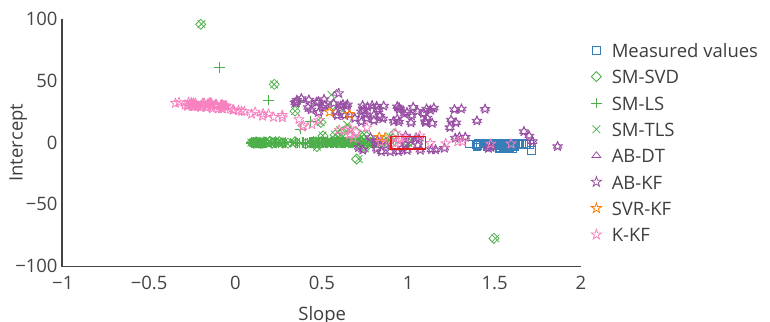
Figure 16. Target plot of the 16 nodes as a function of their slope and intercept in the error model, computed on the entire time interval of study, for each calibration strategy and with the Gaussian plume model. The instruments are not all present: axes were truncated to keep the plot readable. The red rectangle depicts the same requirement as in Figures 11 and 14 for example, a slope in [ 0.9;1.1 ] and an intercept in [ − 5;5 ] . More instruments are inside this area compared to Figure 14 but most of them are outside whatever the in situ calibration strategy